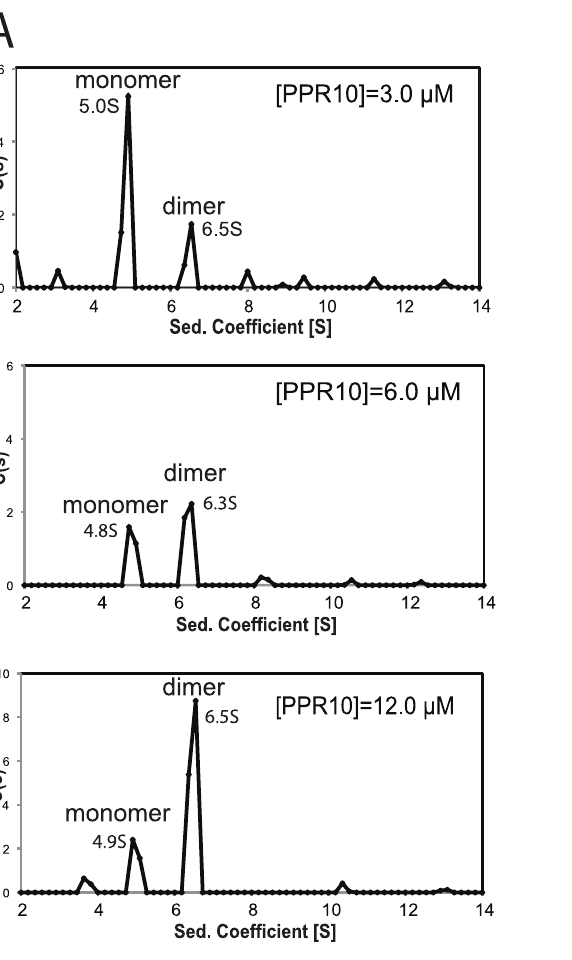
Figure 1. Sedimentation Velocity Analytical Ultracentrifugation of rPPR10 and rPPR10/RNA Complexes. (A) SV-AUC analysis of rPPR10 at 3, 6, and 12 m M. (B) SV-AUC analysis of rPPR10 (3 m M) in the presence of its 17-nt minimal RNA ligand (1.5 m M or 3 m M). The assignment of the two species at , 5S in the top panel as either PPR10 monomer or PPR10/RNA is ambiguous, as variation in apparent S value can result when multiple species of similar abundance are in equilibrium. The root-mean-squared-deviations ranged between .007 and .013. The trace species at low S values may result from contaminating MBP and TEV protease, whereas those of larger size may represent higher order PPR10 oligomers.